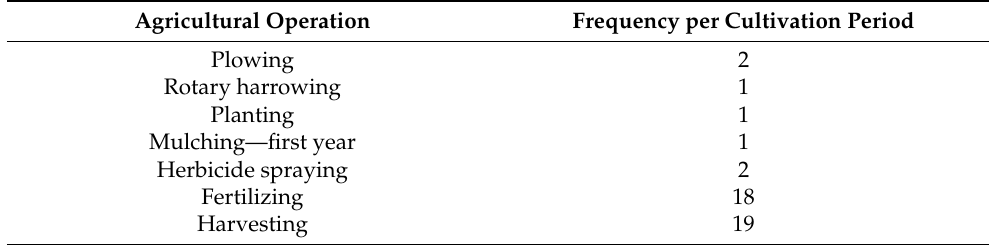
Table 1. Agricultural operations during a 20-year miscanthus cultivation period (adapted from Winkler et al. (2020) [19]).